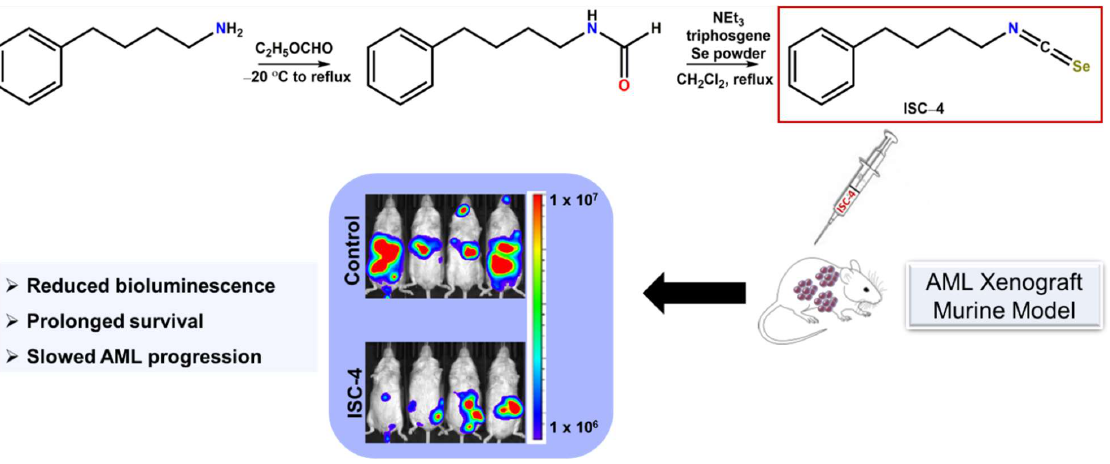
Figure 5. Synthesis of isoselenocyanate (ISC-4) and its efficacy in AML derived xenograft mouse